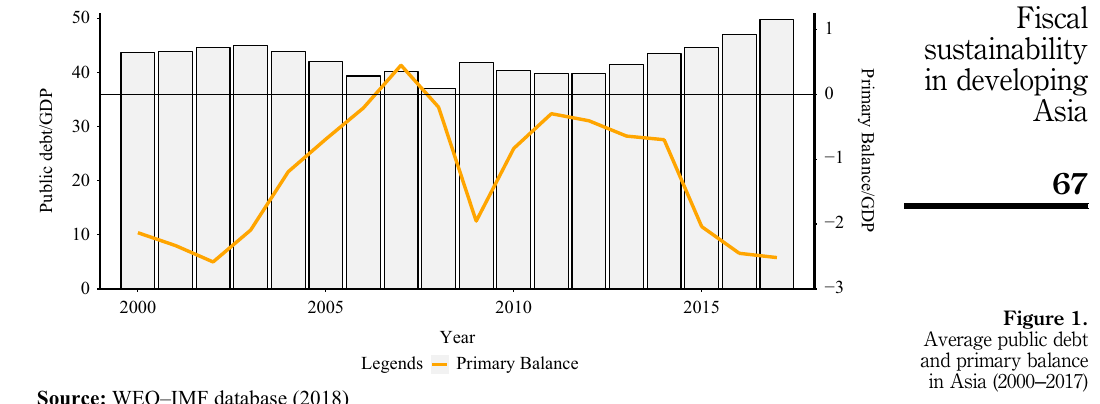
Figure 1. Average public